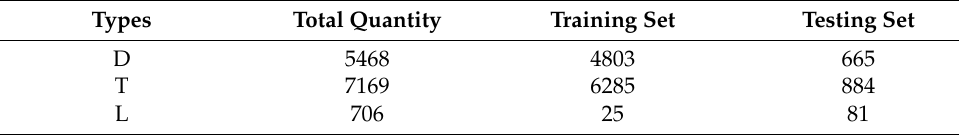
Table 2. Distribution of the data sets for named entities.